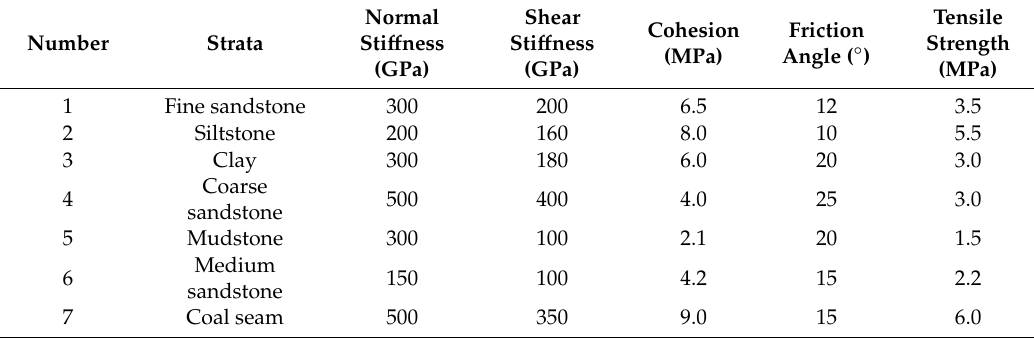
Table 4. Rock physical and mechanical parameters